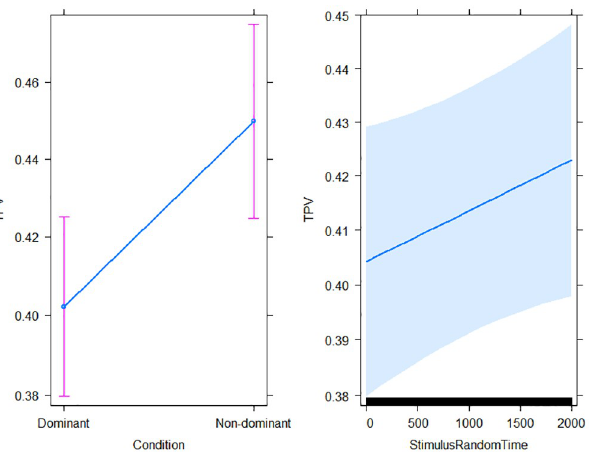
Fig 4. Model mb2 : Condition and StimulusRandomTime effects on the TPV ( n participants = 19, n trials = 2, 903).